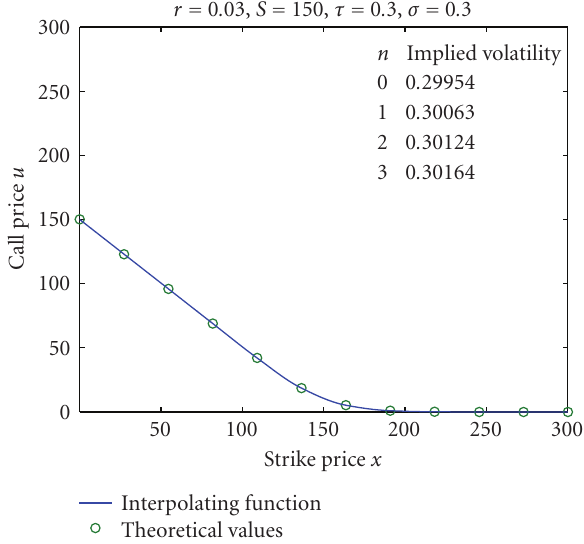
Figure 4.1 . Theoretical call prices and implied volatility using (3.5).